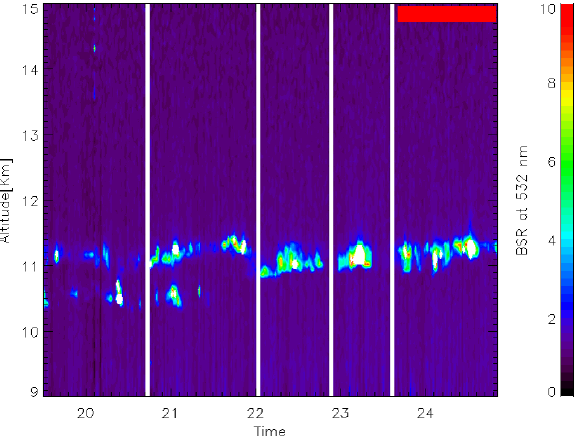
Fig. 2b. Contour plot of the backscattering ratio (BSR) calculated from the elastic channel at 532nm for the lidar session at RTV between 19:31 and 00:50UTC. White vertical lines identify the quasi-stationary periods. The horizontal red bar indicates the quasi- stationary period used in the Match approach (23:37–00:50UTC).